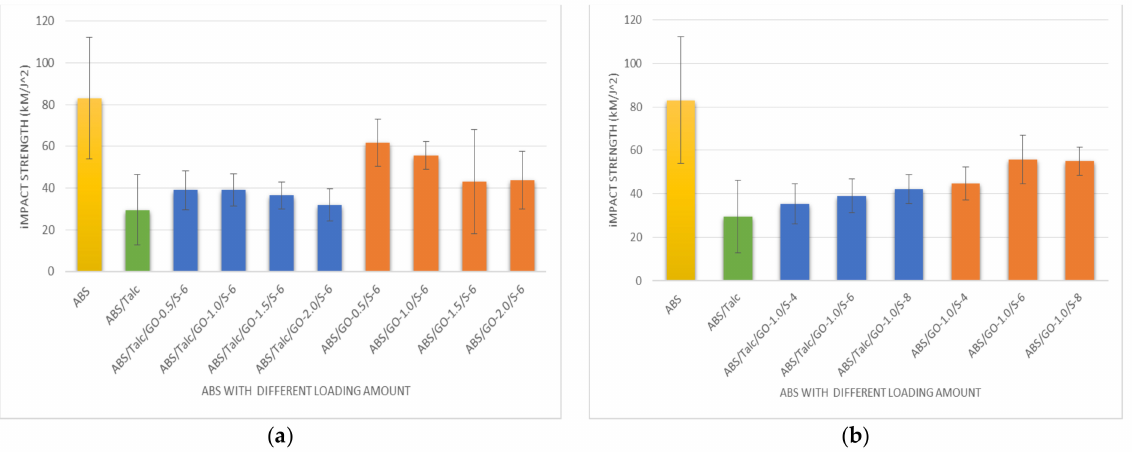
Figure 8. Impact strength of ABS composite with different loading of ( a ) graphene oxide (GO) and ( b )